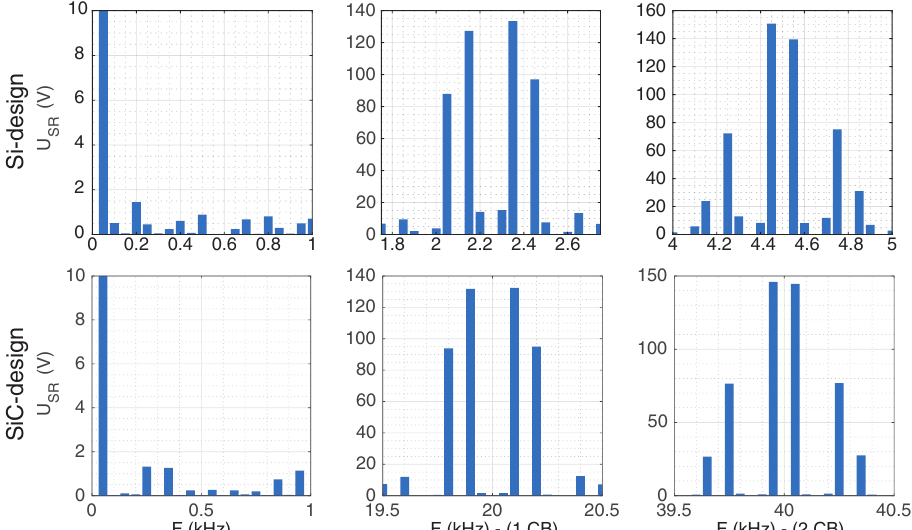
Figure 11. Worst-case harmonic spectrum of the low frequency harmonics and the two first carrier band frequency ranges for both the Si and SiC converter designs; ( Top ) Si-IGBT spectrum with 2.25kHz PWM frequency and 1 µ s deadtime; and ( Bottom ) SiC-MOSFET spectrum with 20kHz PWM frequency and 0.5 µ s deadtime.